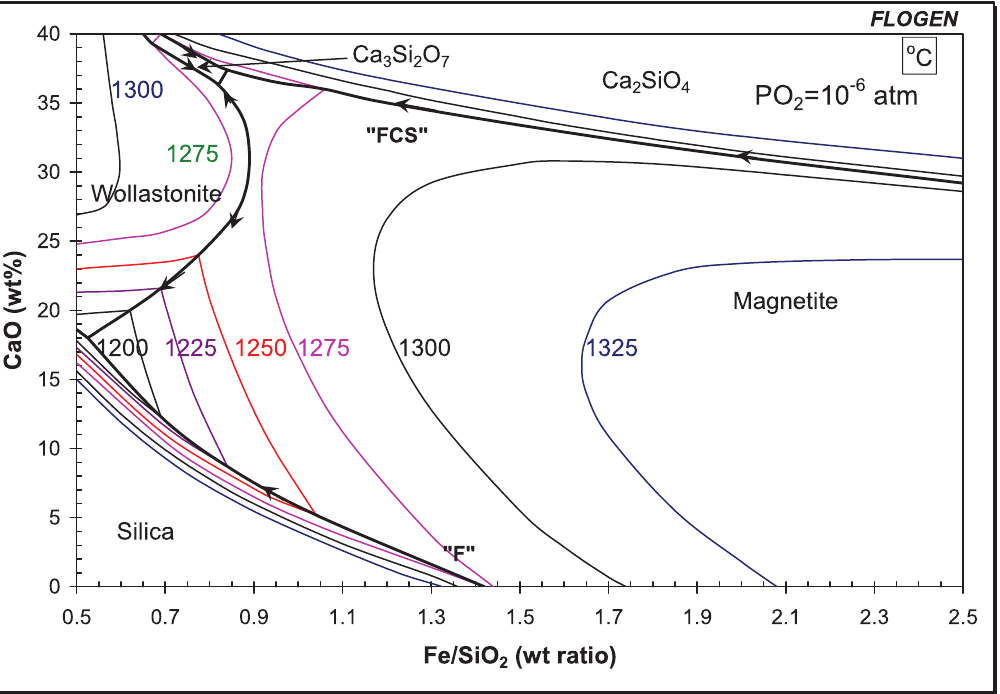
(cid:2) D (cid:2) 6 (atm) close 2